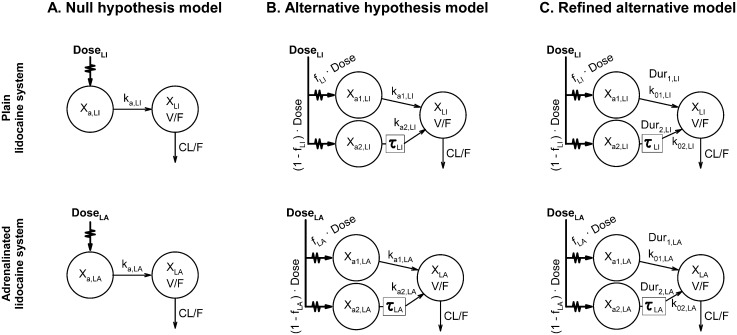
Compartmental pharmacokinetic models used for the analysis of paravertebrally injected lidocaine in dogs.Each model comprises one system for each of the two tested lidocaine formulations. (A) Standard model, with a single first-order absorption rate per system. (B) Alternative model, with two asynchronous first-order absorption rates per system. (C) Refined alternative model, with two time-constrained, asynchronous zero-order absorption rates per system. CL/F, apparent total clearance; Dosej, total amount of lidocaine administered (hereafter, subscript j = “LI” codes for the plain lidocaine formulation, and j = “LA” the adrenalinated lidocaine formulation); Dur1,j, duration of zero-order absorption from the first (early) absorption compartment; Dur2,j, duration of zero-order absorption from the second (late) absorption compartment; fj, dose fraction entering the first (early) absorption compartment; ka,j, first-order absorption rate constant; ka1,j, first-order absorption rate constant of the first (early) absorption compartment; ka2,j, first-order absorption rate constant of the second (late) absorption compartment; k01,j, zero-order absorption rate of the first (early) absorption compartment; k02,j, zero-order absorption rate of the second (late) absorption compartment; V/F, apparent distribution volume; τi, lag-time of the second (late) absorption process; Xj, amount of drug present in the disposition compartment; Xa,j, amount of drug present in the absorption compartment; Xa1,j, amount of drug in the first (early) absorption compartment; Xa2,j, amount of drug in the second (late) absorption compartment.